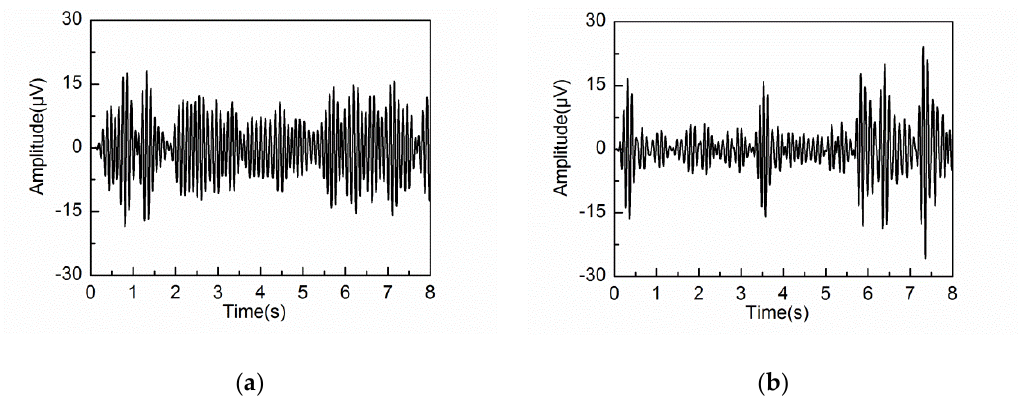
Figure 14. Extracted alpha rhythm by infinite impulse response (IIR) under: ( a ) eyes-closed condition; ( b ) eyes-open condition.